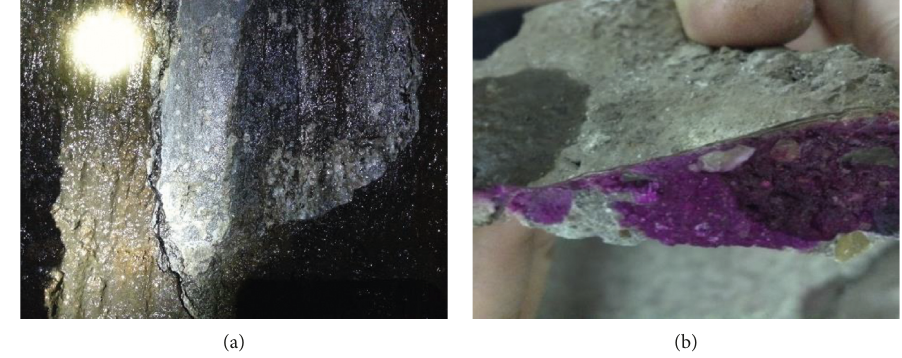
Figure 3: Compact concrete with a dense layer ( − 284m).